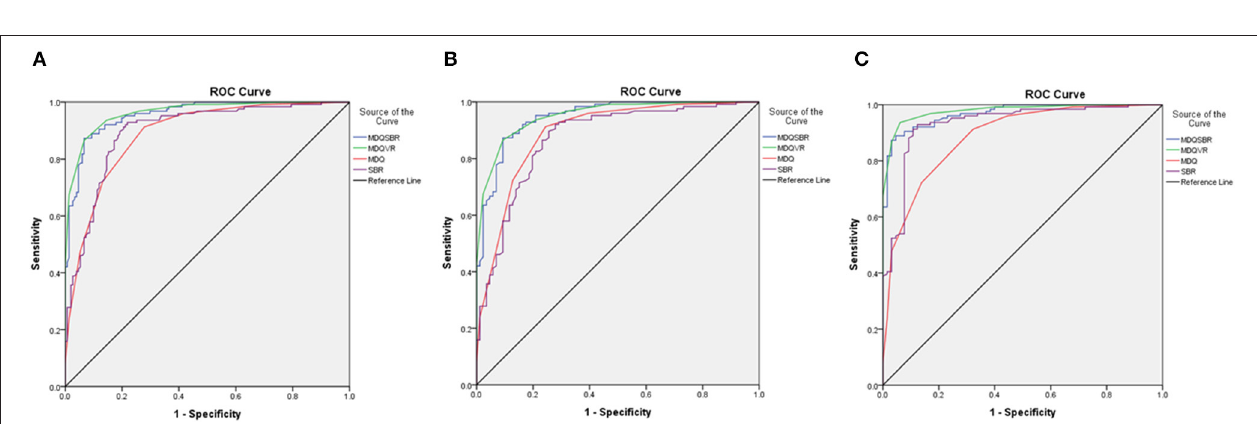
FIGURE 2 | Comparison of MDQ, SBR, MDQSBR, and MDQVR among the ND, AD, and DLB groups. MDQ, motor dysfunction questionnaire in the history-based artificial intelligence clinical dementia diagnostic system; SBR, striatal–background ratio of dopamine transporter imaging; MDQSBR, the composite scale of MDQ and SBR; MDQVR, the composite scale of MDQ and DAT VR scale; ND, non-dementia control; AD, Alzheimer’s disease; DLB, dementia with Lewy bodies.